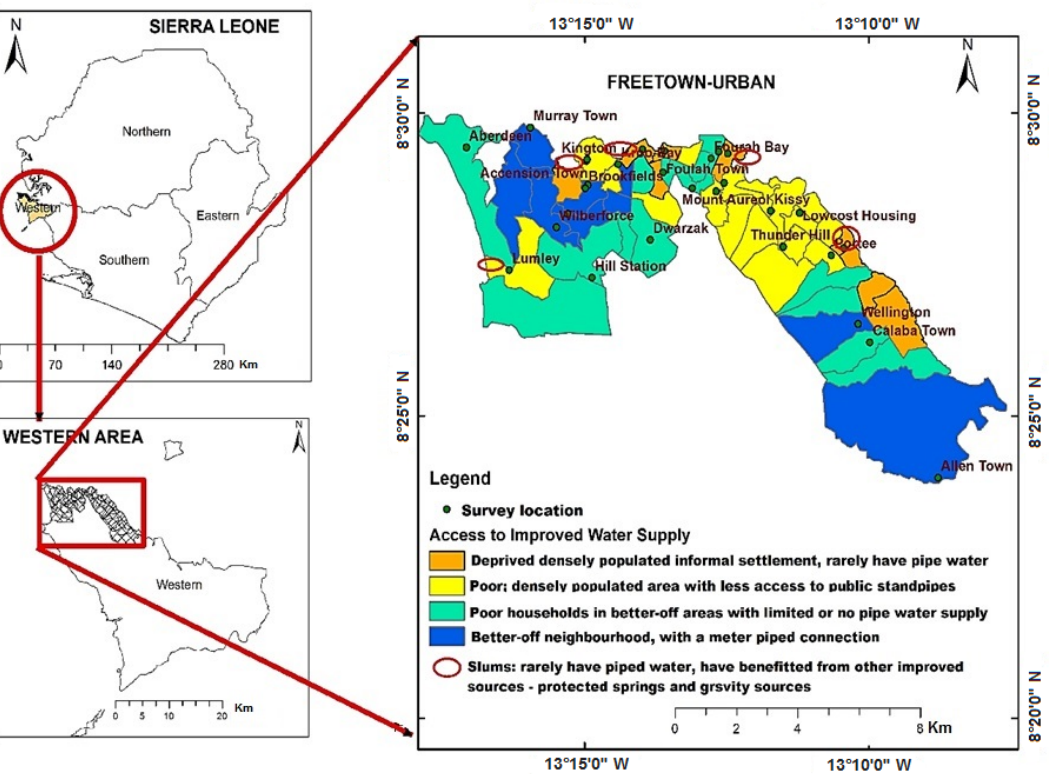
Figure 1. Map of study area with improved access to piped connection where research is conducted.